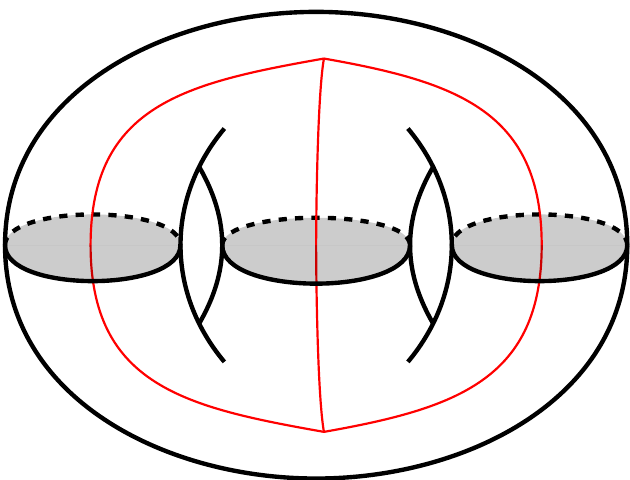
Figure 1. A genus 2 surface, which is cut into two pairs of pants glued together along the three black circles. Along each of the three circles we can insert a projection onto the descendants of a primary of dimension (cid:1) i ( i = 1 ; 2 ; 3) to obtain the block F ( f (cid:1) i g ; c ; (cid:28) ). The dual handlebody is found by ‘(cid:12)lling in’ the surface, as indicated by the shaded disks. The block F ( f (cid:1) i g ; c ; (cid:28) ) can be computed in the bulk in a semi-classical approximation, valid in the limit 1 (cid:28) (cid:1) i (cid:28) c , by computing the action of the network of bulk geodesics indicated in